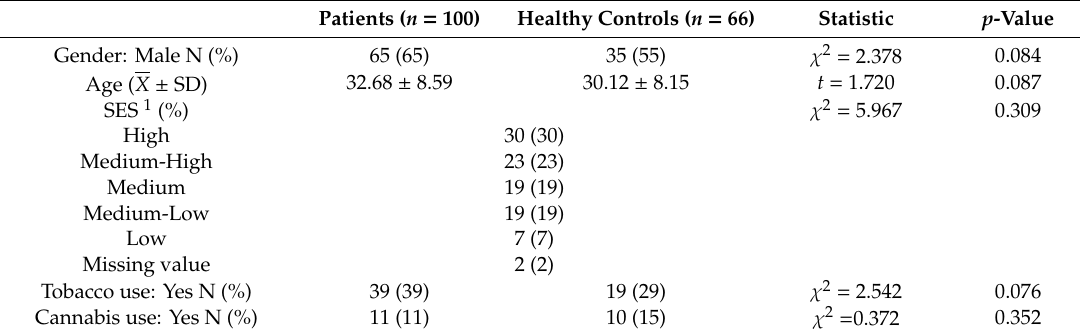
Table 1. Sociodemographic, functional, clinical, and neuropsychological variables for patients with severe mental illness and healthy